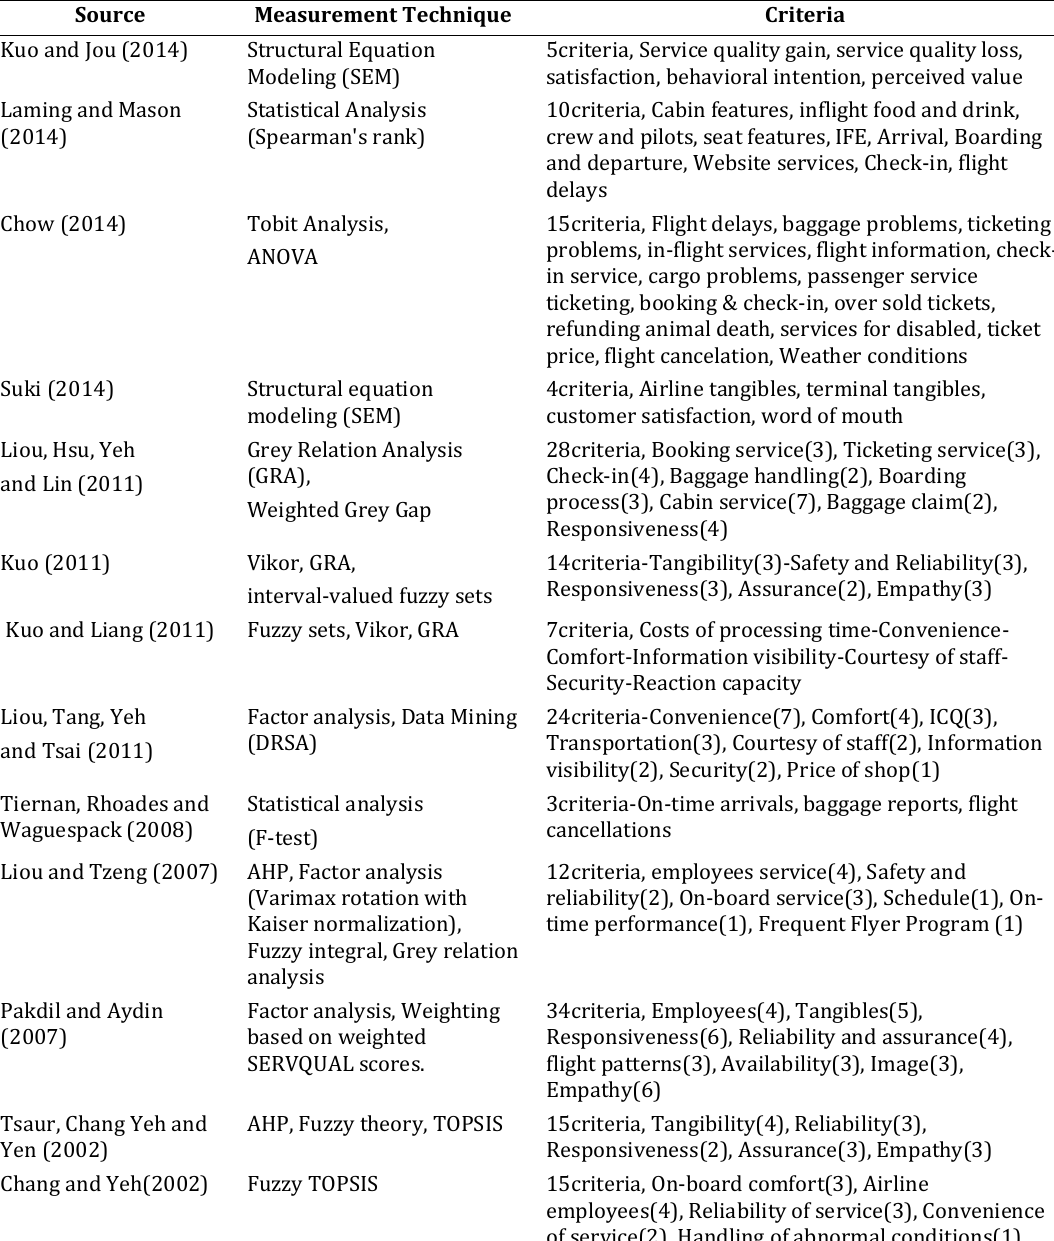
Table 3. Review of some of major airline service quality evaluation criteria and